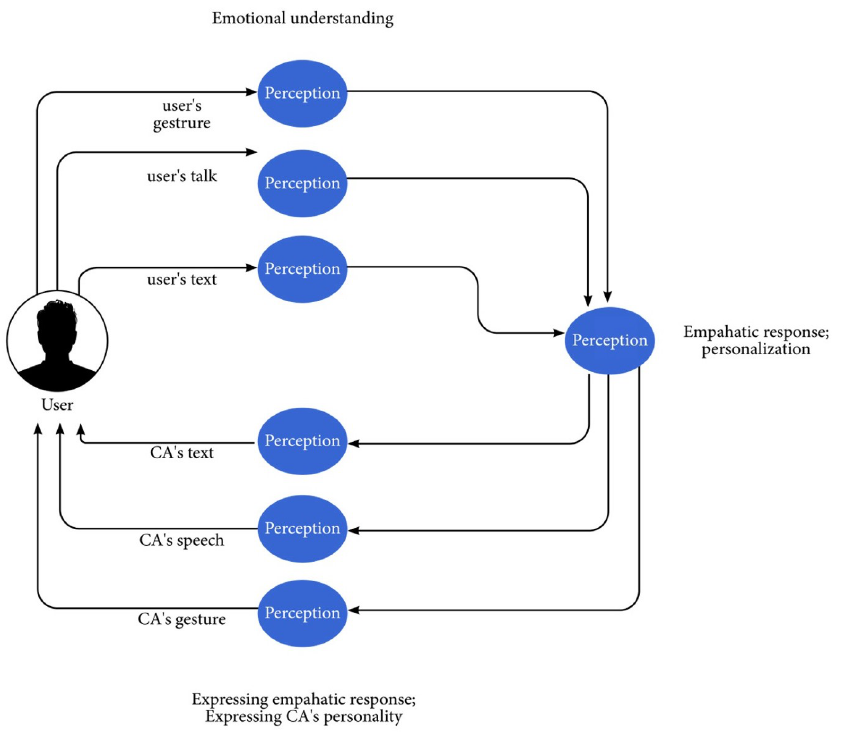
Figure 8. Human-related aspects of the CA: emotion sensitivity, personality expression, and adapta- tion to the user’s taste and